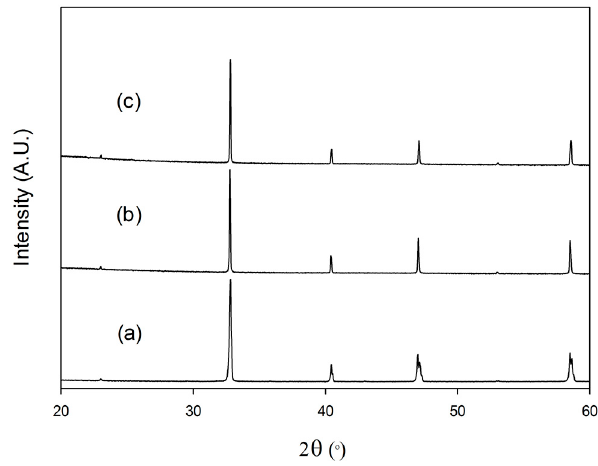
Figure 10. X-ray diffraction patterns for ( a ) SrFeO 3- δ , ( b ) SrFe 0.95 B 0.05 O 3- δ , ( c ) SrFe 0.9 B 0.1 O 3- δ . Cell parameters and site occupancies were determined using the Rietveld method (an example fit is shown in Figure 11).